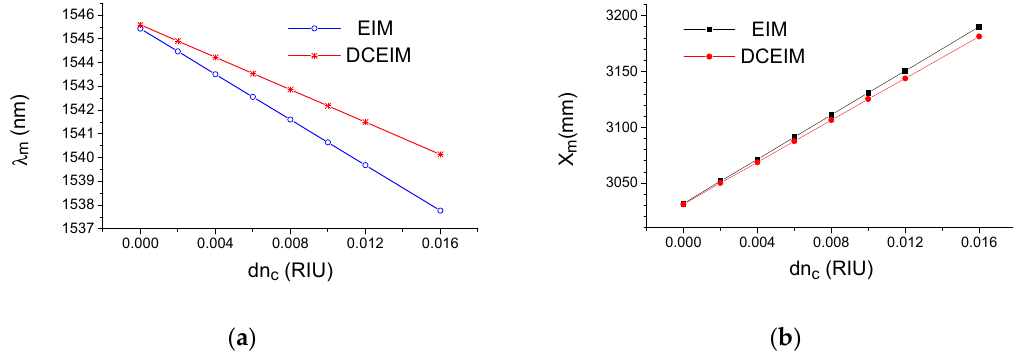
Figure 3. Simulated characteristics of the optical sensors obtained under the effective index method (EIM) and the dispersion compensated effective index method (DCEIM) approximations for the different index variations dn c of the environment (water). ( a ) Wavelength position λ m of the maximum transmitting power to the leaky wave propagated in segmented grating; ( b ) the coordinate position X m of the maximum transmitting power in the focal plane of the ideal lens with 10 mm focal length. Simulation by the 2D FDTD.